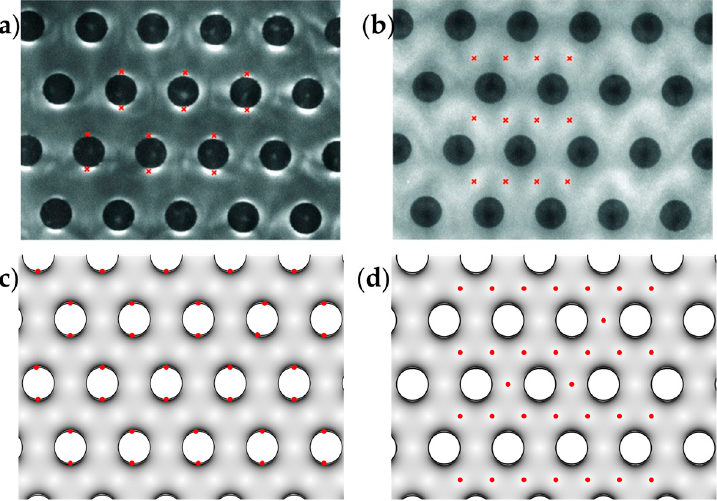
Figure 4. The particle spatial locations for positive dielectrophoresis force (pDEP) ( a , c ) and positive dielectrophoresis force (nDEP) ( b , d ). ( a ) Concentration of DNA on the edges of 3D electrodes in pDEP [50]; ( b ) Concentration of DNA in the distances between 3D electrodes in nDEP [50]; ( c ) The result of validation simulation in pDEP that shows particles stuck to the edge of 3D electrodes; ( d ) The result of validation simulation in nDEP that shows particles located at the gaps between the electrodes.